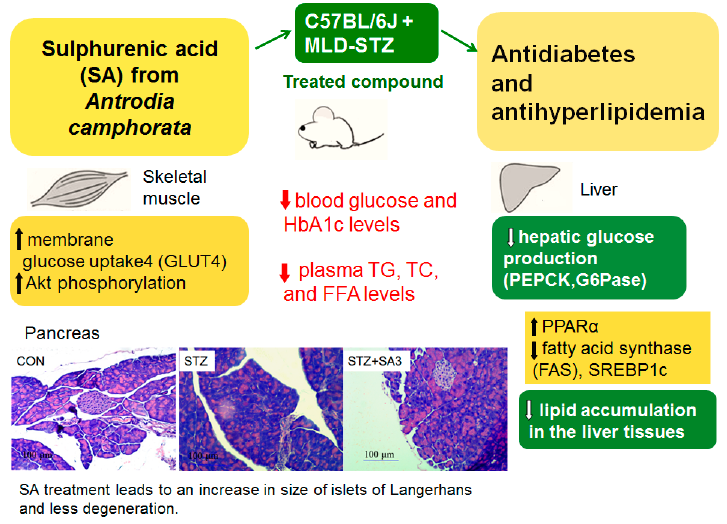
Figure 8. The graphical abstract of sulphurenic acid (SA) in multiple low dose (MLD) streptozotocin (STZ)-induced diabetic mice.